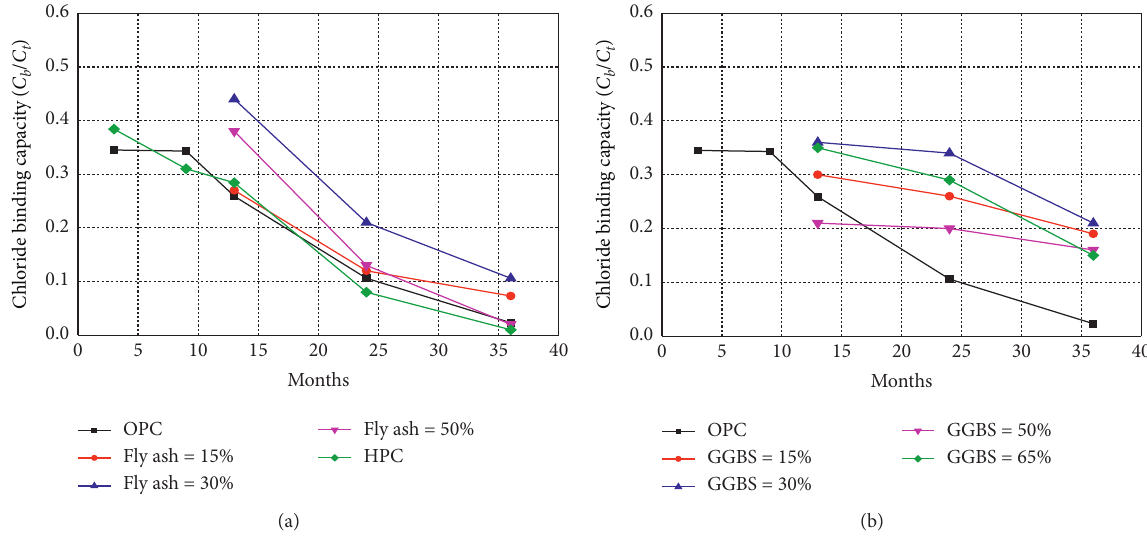
Figure 11: The bound chloride ion content of concrete exposed to submerged zone for 3 years. (a) With fly ash. (b) With GGBS.